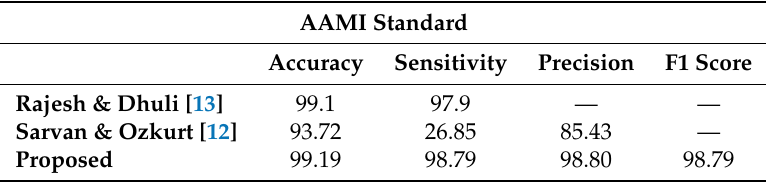
Table 15. Comparison of the method proposed with other works using the standard